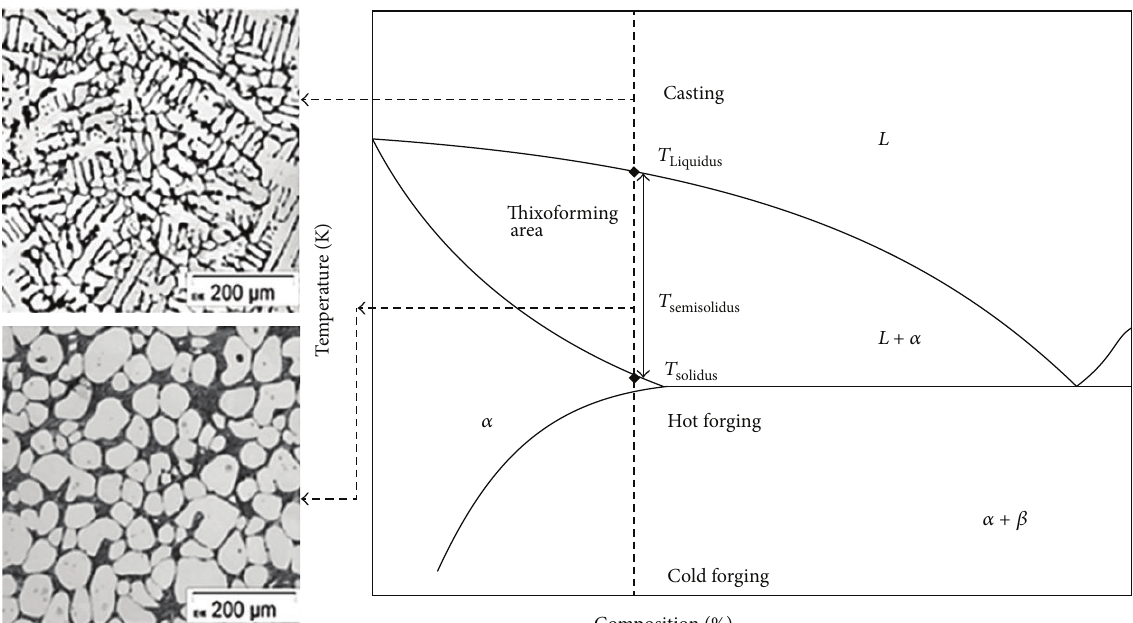
Figure 1: Micrograph of dendritic and globular structures in a semisolid alloy; simple eutectic phase diagram for steel grade X210CrW12 [4].